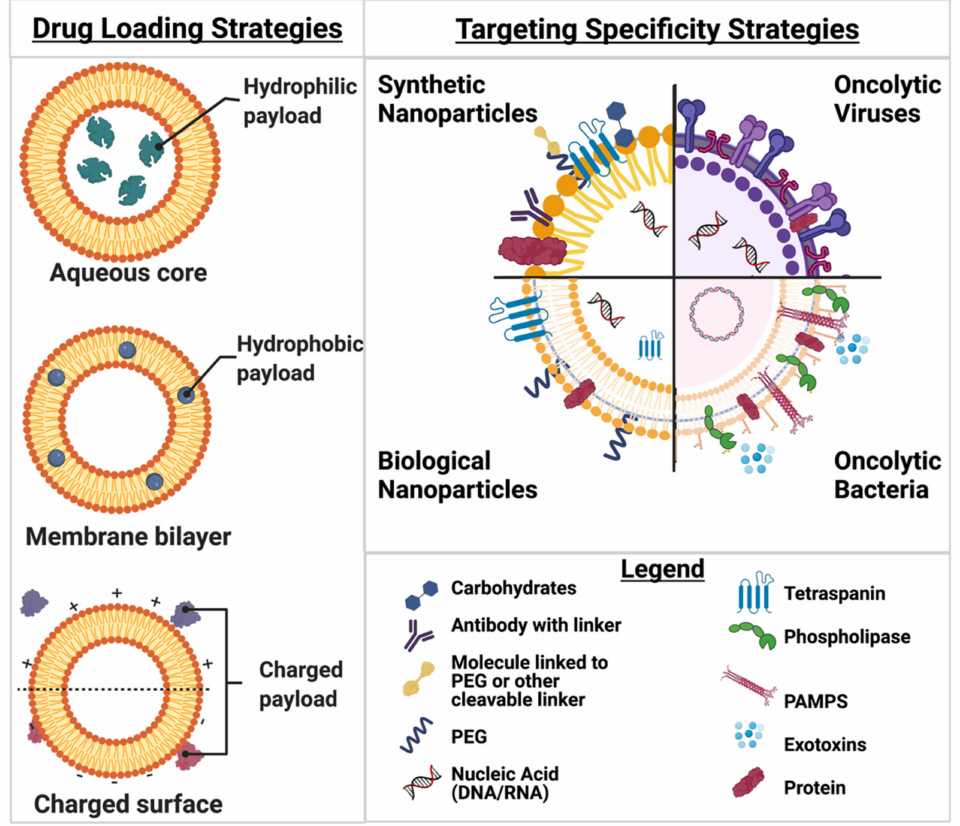
Figure 2. Representation of potential drug loading and targeting modifications